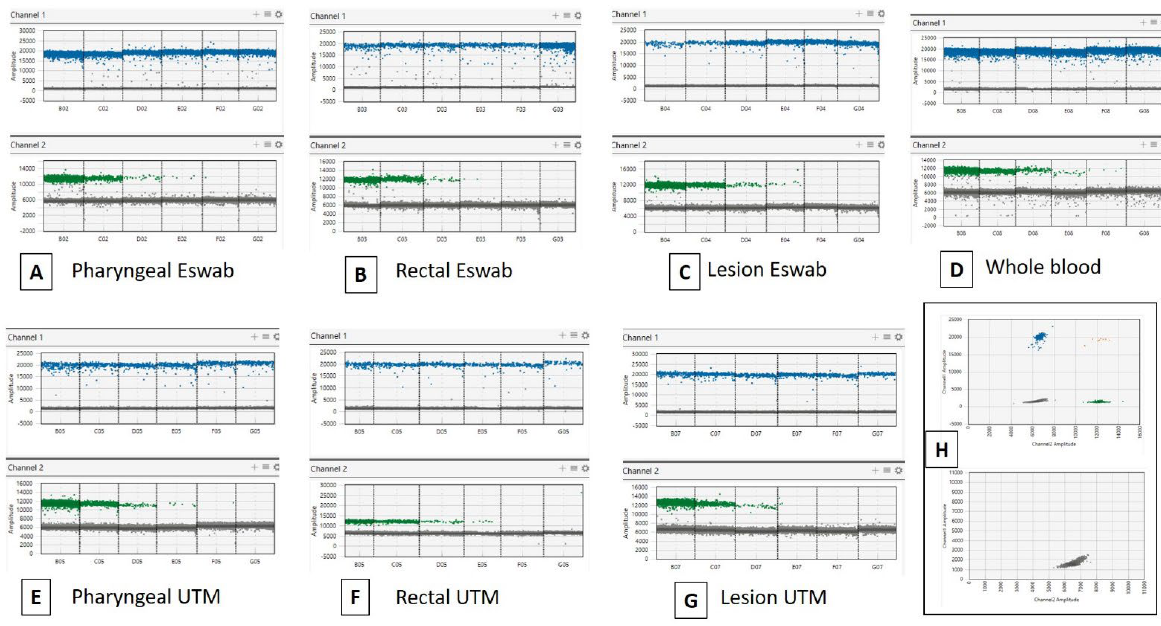
Figure 1. Evaluation of the ddPCR duplex assay (MPXV as Channel 1 and RPP30 as Channel 2) performance using MPXV synthetic amplicon Gblock Sequence as reference DNA. Standard curves were obtained from 10-fold serial dilutions of the reference DNA (3.5 × 10 4 copies/ µ L) in four biological matrices in two different transport media (UTM and eSwab) ( A – G ). Positive samples (up) and negative samples (below) ( H ).